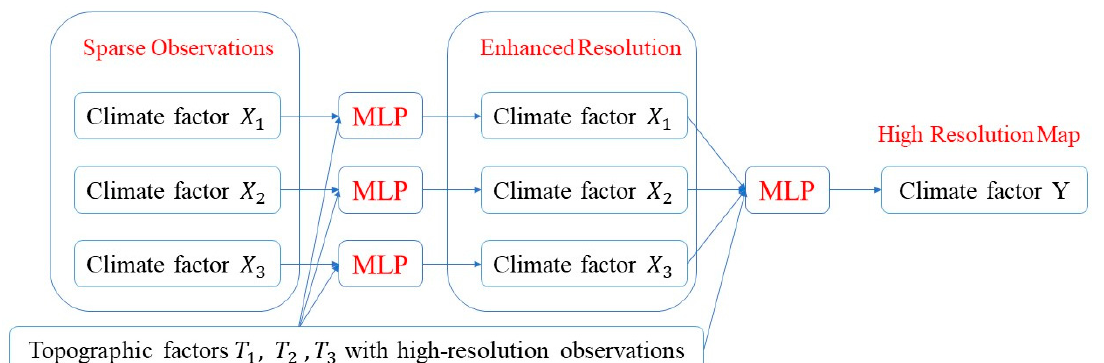
Figure 1. Using the hybrid of MLPs to generate a high-resolution map of climate factor Y by using three topographic factors T 1 , T 2 and T 3 and sparse climate observations X 1 , X 2 and X 3 . Our algorithm consisted of two stages: In stage 1, we established an MLP model for each climate factor by viewing it as a function of three topographic factors (longitude, latitude and altitude). This MLP model could be trained by using the longitude, latitude and altitude of meteorological stations and sparse observations of each climate